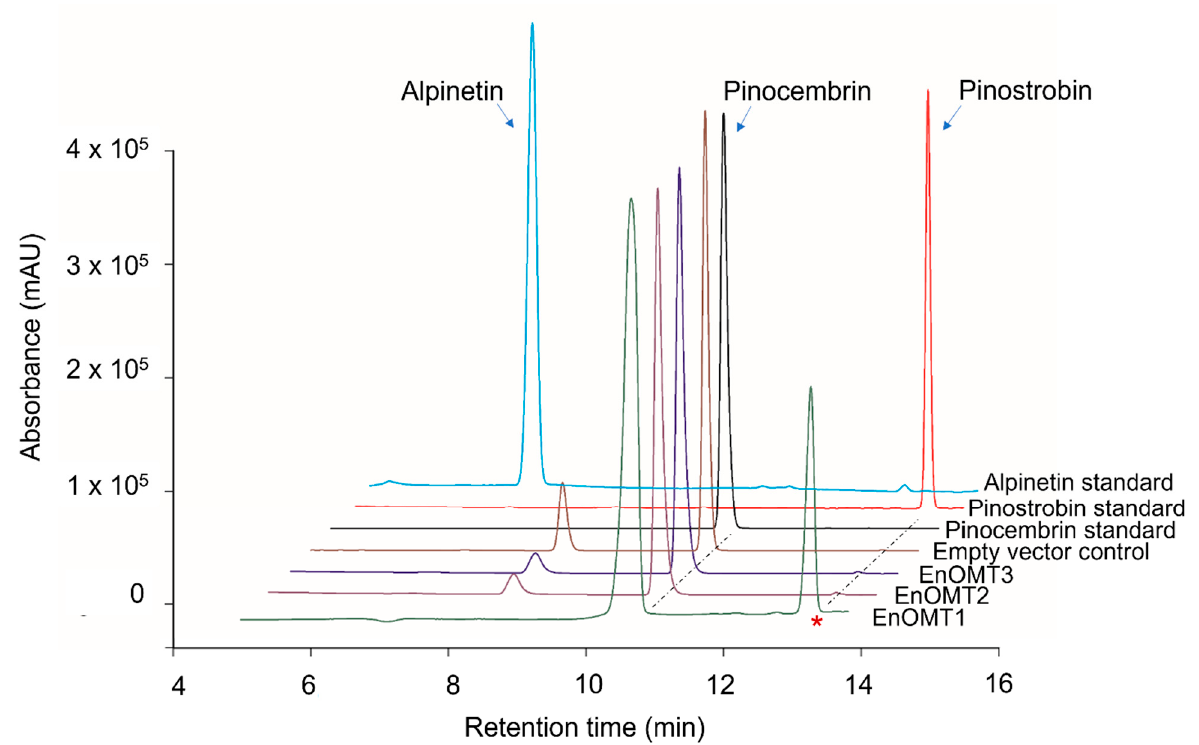
Figure 3. High-performance liquid chromatography (HPLC) chromatograms showing assay prod- ucts of EnOMT1-3 with pinocembrin as substrate aligned with empty vector control and flavanone standards. The asterisk denotes the peak corresponding to the methylated assay product.